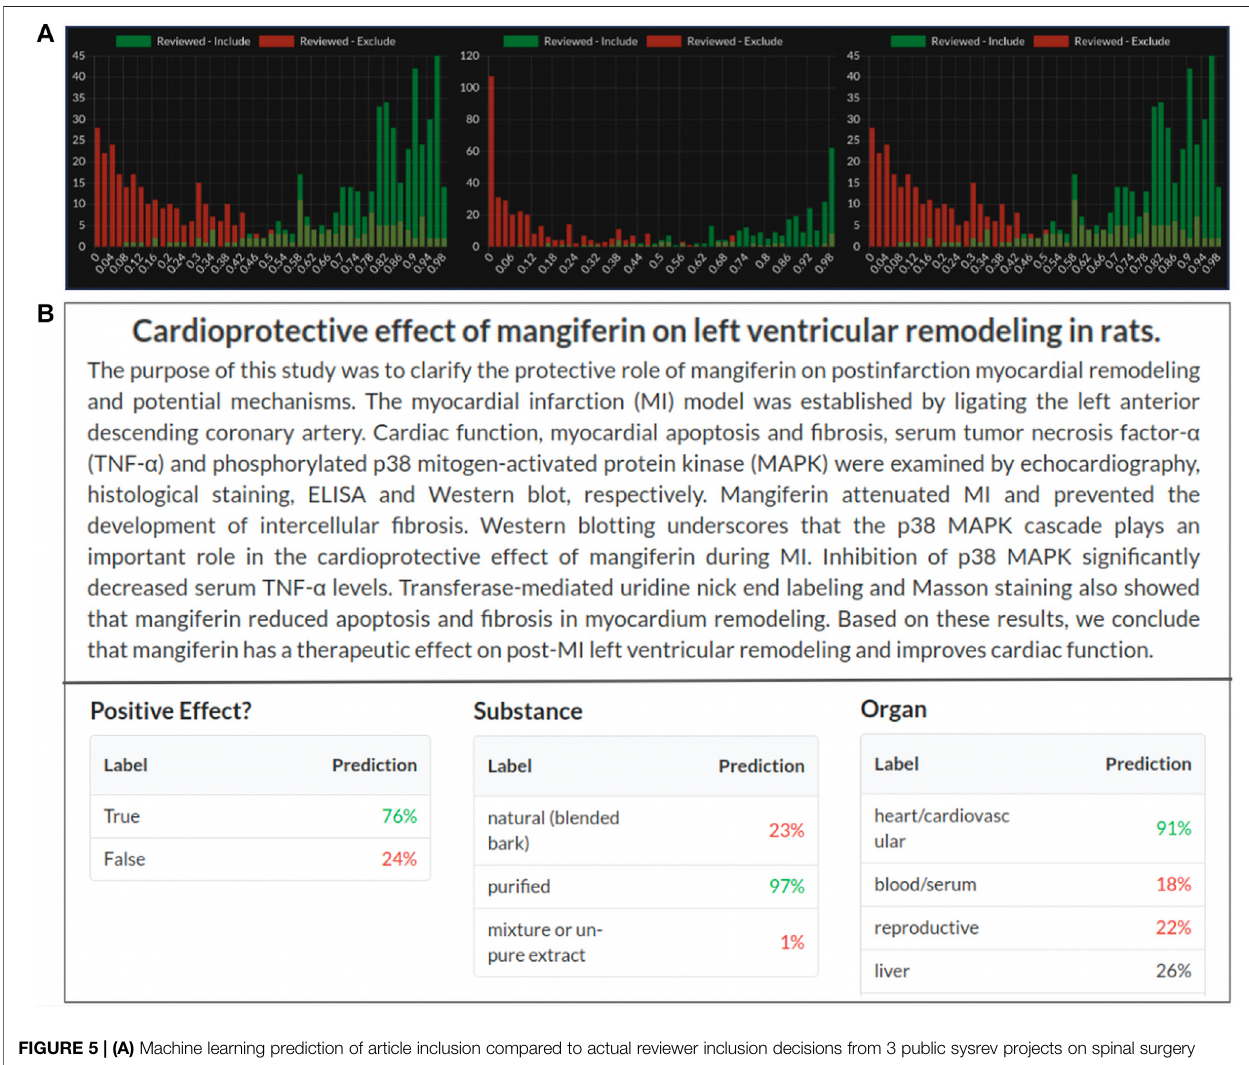
FIGURE 5 | (A) Machine learning prediction of article inclusion compared to actual reviewer inclusion decisions from 3 public sysrev projects on spinal surgery sysrev.com/p/14872, sysrev.com/p/14873, sysrev.com/p/14874. (B) Sysrev categorical and Boolean predictions. Sysrev predictions correctly identify that this article references a “ positive effect ” on “ heart/cardiovascular. ” They provide a strong prediction of “ puri fi ed ” mangiferin substance, even though the article does not explicitly specify this. Model predictions can be seen on every article in a project. This screenshot comes from an Insilica.co project on Mangiferin (sysrev.com/p/24557/